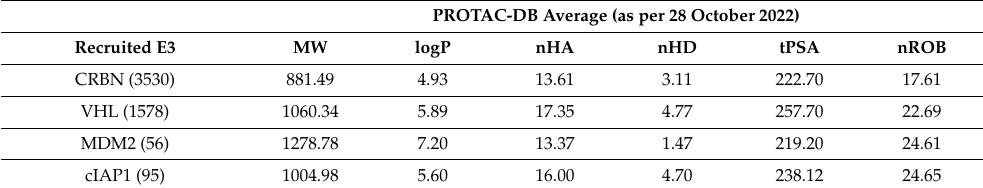
Table 1. Physicochemical properties comparison among published PROTACs.